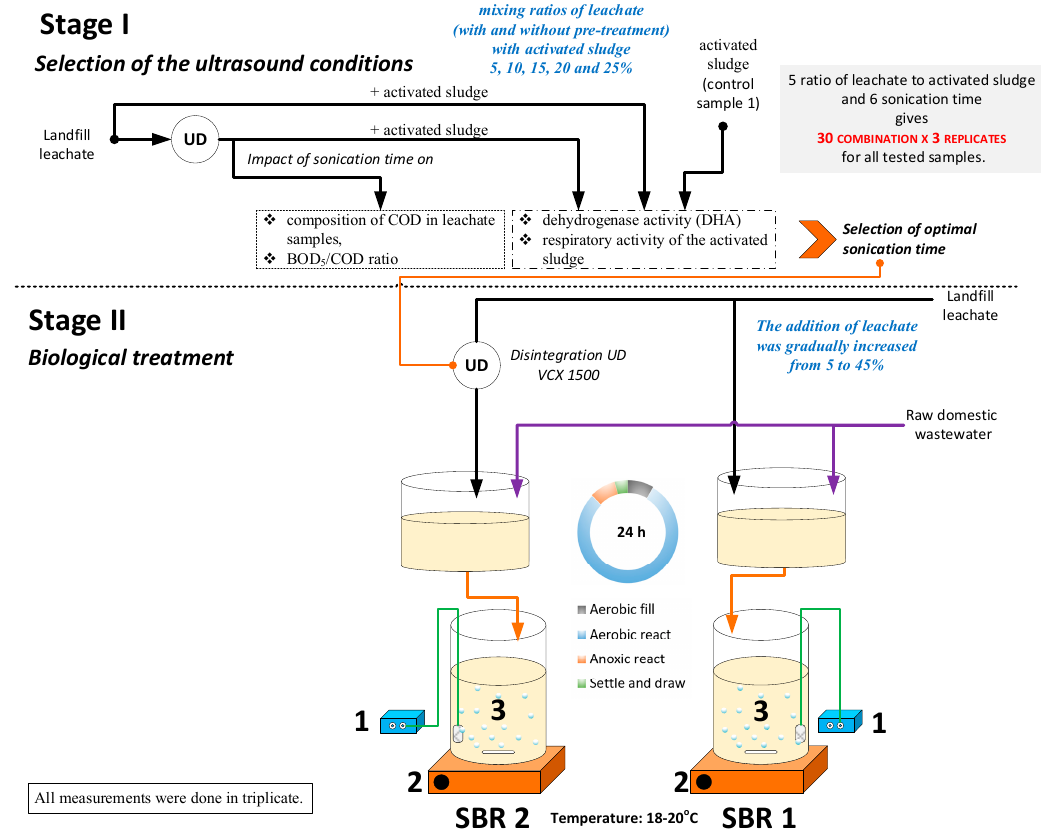
Figure 2. Experimental set-up and operational modes of the SBR; where: 1—air pomp, 2—magnetic stirrer, 3—SBR.